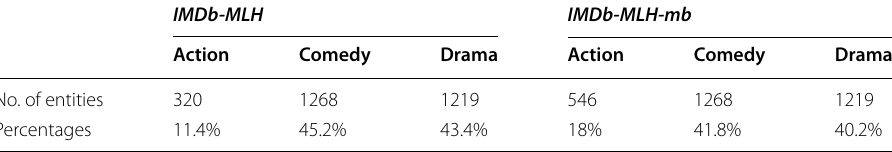
Table 3 Distribution of the classes (i.e., movie genres) for IMDb-MLH and